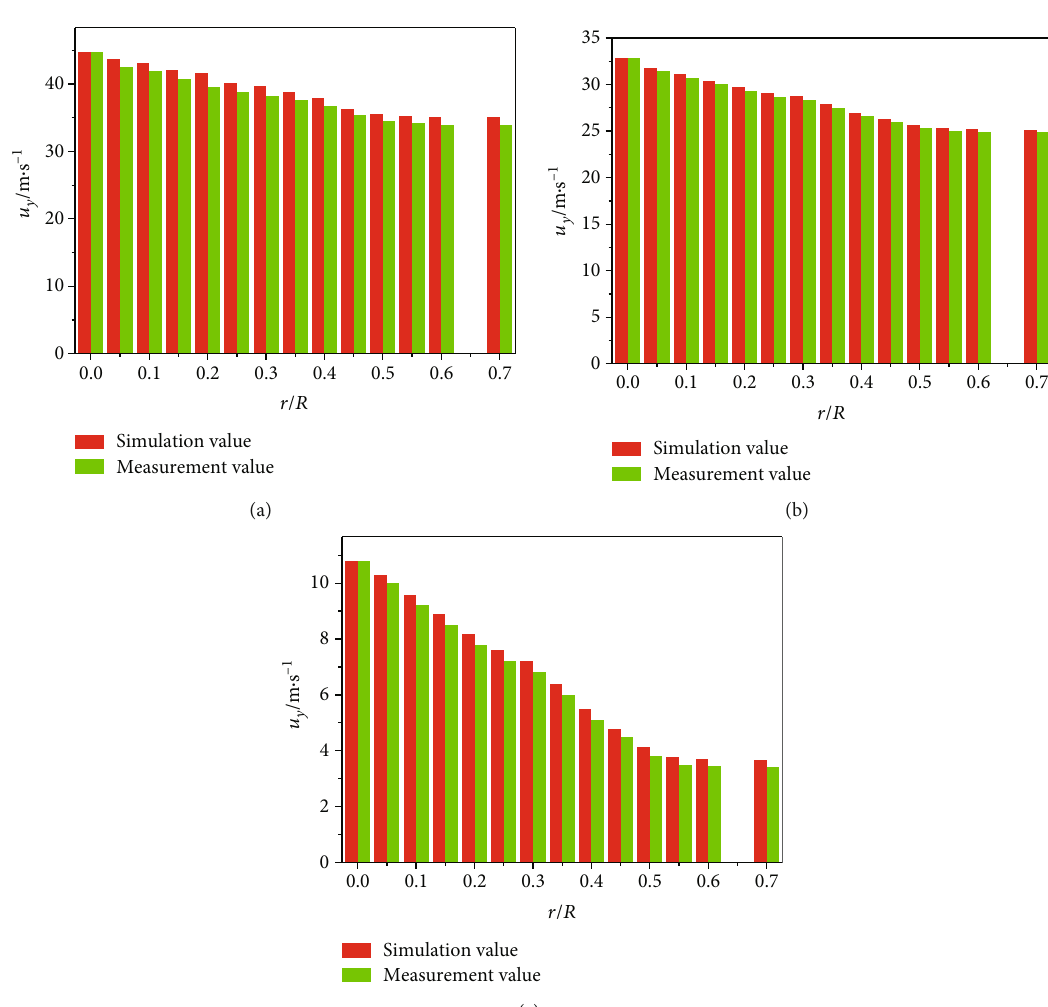
Figure 4: Comparisons of the measurement values and the simulation